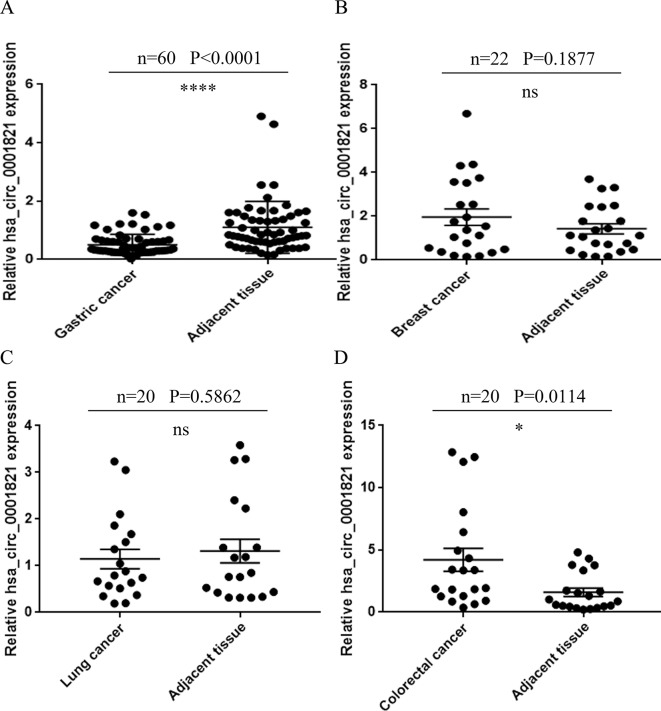
Validation of hsa_circ_0001821 expression in different tumor tissues. (A) Extended verification of hsa_circ_0001821 expression in 60 pairs of gastric cancer (GC) tissues by quantitative real-time PCR (qRT-PCR). Detection of hsa_circ_0001821 expression in breast cancer (B, n = 22), lung cancer (C, n = 20), and colorectal cancer tissues (D, n = 20). *P<0.05 and ****P<0.0001 were considered significant.